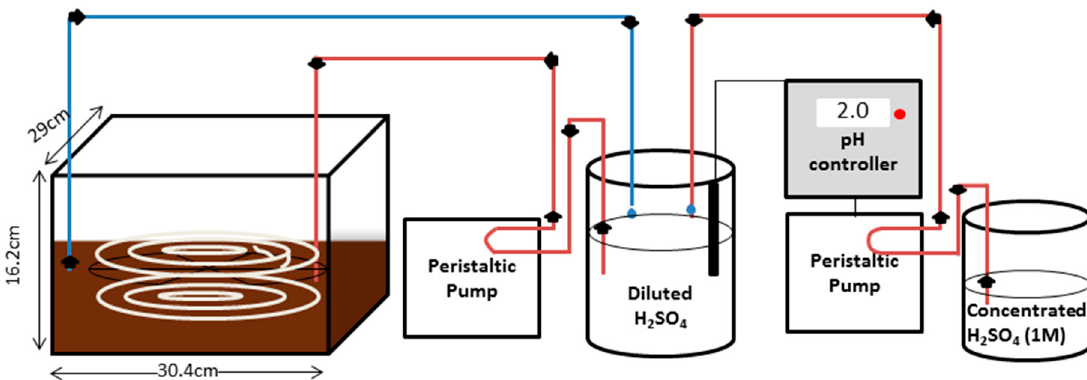
Figure 6. Schematic of ammonia capture system. Diluted H 2 SO 4 is pumped from a 1 L beaker throughout the system, through the double-web structure GPM which is immersed in a donor solution (NH 4 Cl, digestate or manure) and back to the 1 L beaker. When the pH of the diluted H 2 SO 4 exceeds 3, a controller activates a pump transferring 1M H 2 SO 4 to the diluted H 2 SO 4 beaker, lowering the pH.